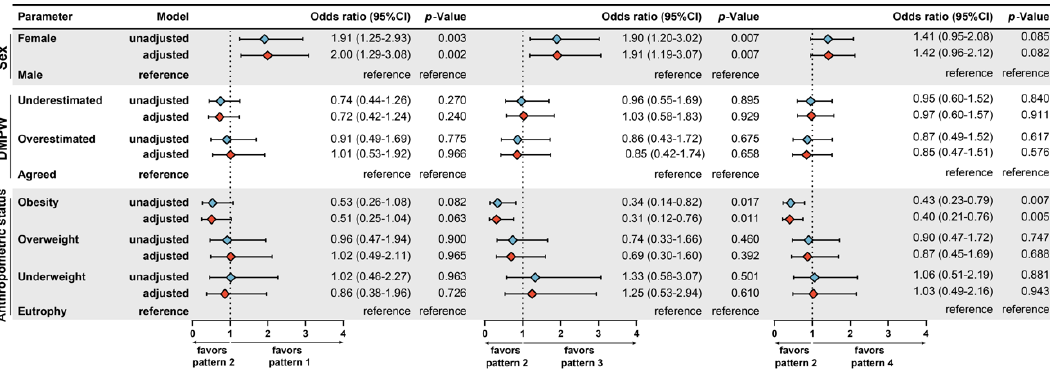
Data represent mean and standard deviation of values calculated for abundance of consumption of each food or food group (unit = % consumption relative to total diet). The one-way ANOVA test was used to examine the differences in values of abundance of consumption of each indicated food group, relative to total diet, between the dietary patterns identified by the hierarchical cluster analysis